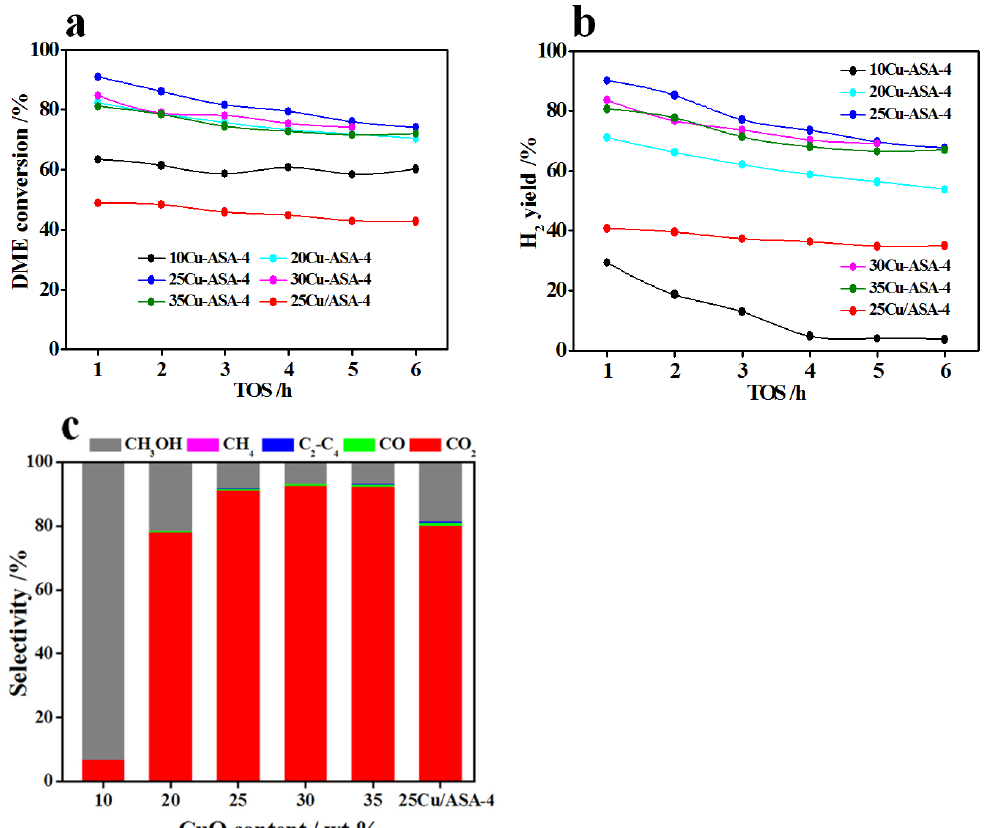
Figure 5. The time-on-stream DME conversion ( a ), H 2 yield ( b ), and the selectivity of the carbon- containing products at a TOS of 6 h ( c ) for the SRD reaction of the x Cu–ASA-4 and 25Cu/ASA-4 catalysts under the conditions of 300 °C, 0.1 MPa, and GHSV of 4000 h − 1 .